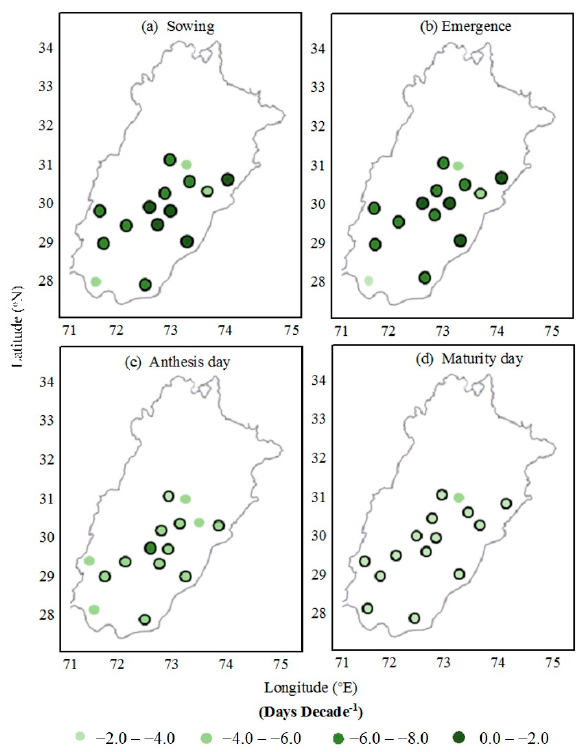
Figure 3. Observed trends in phenological stages of cotton sown from 1980 to 2015 in Punjab, Pakistan; ( a ) sowing; ( b ) emergence; ( c ) anthesis and ( d ) maturity. Circles with black border indicate statistically significant trends at p = 0.05 probability level.